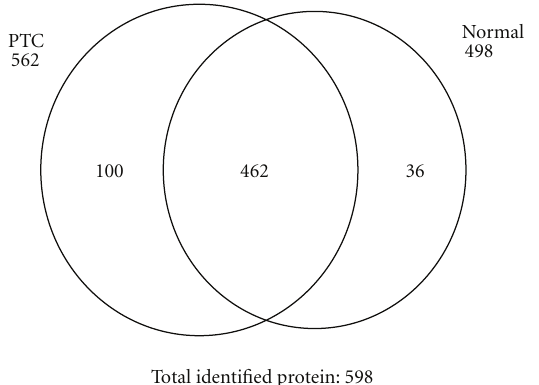
Figure 1: Venn diagram of identified proteins. In PTC, 562 proteins were identified, and 498 were identified in normal thyroid tissue, with 462 proteins being common to both PTC and normal thyroid tissue. The total number of identified proteins was 598 (Normal; normal thyroid tissue; PTC; Papillary thyroid